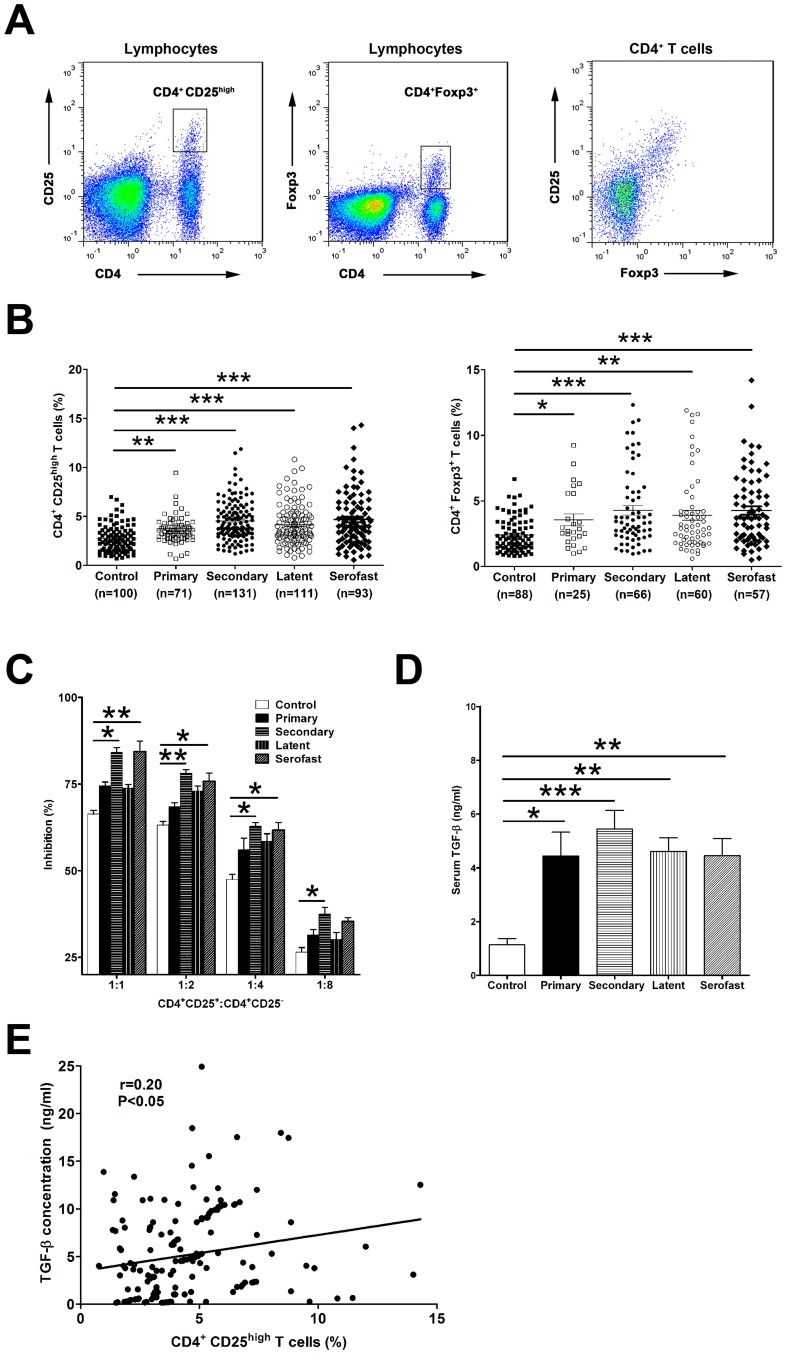
Treg activity in the peripheral blood of early and serofast syphilis patients.(A) Peripheral blood mononuclear cells (PBMC) were stained for flow cytometric analysis and lymphocytes were gated according to forward and side scatter characteristics. Representative plots show the gates of CD4+ CD25high and CD4+ Foxp3+ T cells in the lymphocyte gate. CD25 and Foxp3 expression among CD4+ T cells are also shown. (B) The percentage of CD25high and Foxp3+ among CD4+ T cells in peripheral blood of healthy controls, and in patients with primary, secondary, latent and serofast syphilis. Individual frequencies for every patient analyzed are shown. (C) CD4+ CD25+ T cells and CD4+ CD25− T cells were purified from peripheral blood of healthy donors, and patients with primary, secondary, latent and serofast syphilis. The mean percent inhibition of the proliferative response by CD4+ CD25+ T cells derived from three to five individuals per group is shown. Results are representative of three independent experiments. (D) Serum concentrations of TGF-β were measured in healthy controls, and in patients with primary, secondary syphilis, latent, and serofast syphilis. Results represent the mean or the mean ± SEM. (E) Correlation of serum TGF-β concentration with circulating CD4+ CD25high Treg frequencies in syphilis patients (n = 176). Each dot represents an individual patient. B, Kruskal-Wallis test; C and D, One-way ANOVA; E, Pearson's correlation. *, P<0.05; **, P<0.01; ***, P<0.001.